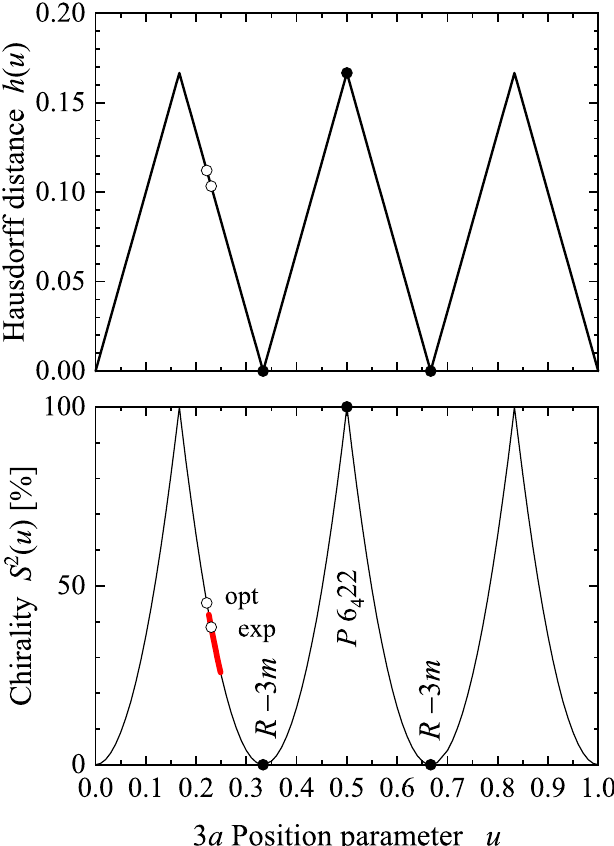
atom from 3a with (0.23, 0, 2/3) to (1/3, 0, 2/3) changes the symmetry to space group R 3 m (166) while the structure becomes achiral. However, Se at high pressure (>80 GPa) adopts a β -Po structure, which also belongs to space group R 3 m with the atoms on (0, 0, 0) [46]. The chirality measures h and S 2 of the (Se, hP3, 152, P 3 1 21) structure are shown in Figure 5. The maxima of the chirality measure appear at 1/6, 1/2, and 7/6. At u = 1/2, the structure adopts the P 6 2,4 22 space group, depending on whether it started with the 3 1 or 3 2 screw rotation. As expected, the chirality measure becomes zero at u = 0, 1/3, 2/3, and 1 when the structure becomes achiral. Further, at u Se = 0.23 and u Te = 0.2636 as reported = 17.5%, = 38.4% and S 2 for Se and Te, the chirality measures are approximately S 2 Te Se respectively. Moreover, the u parameter can be varied by external pressure. In experiments performed on Se, it varies from 0.2254 under ambient conditions to 0.2487 at a pressure of 86 GPa [47], which results in a decrease of S 2 from 41.9 to 25.8%. Se